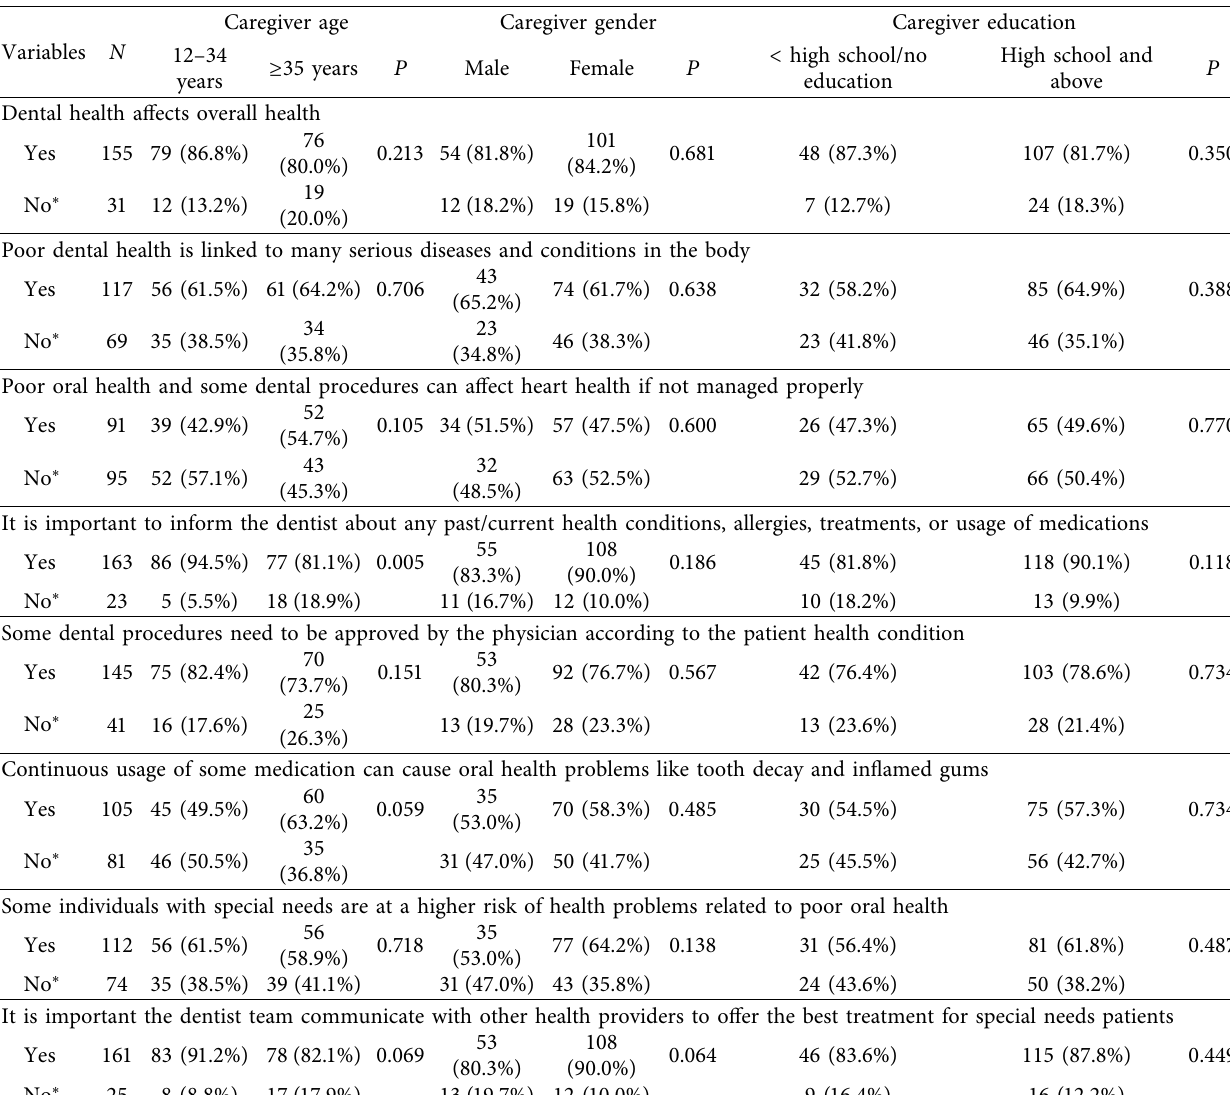
Table 3: The association between caregivers’ age, gender, and education with perception of caregivers about the relationship between oral health and overall